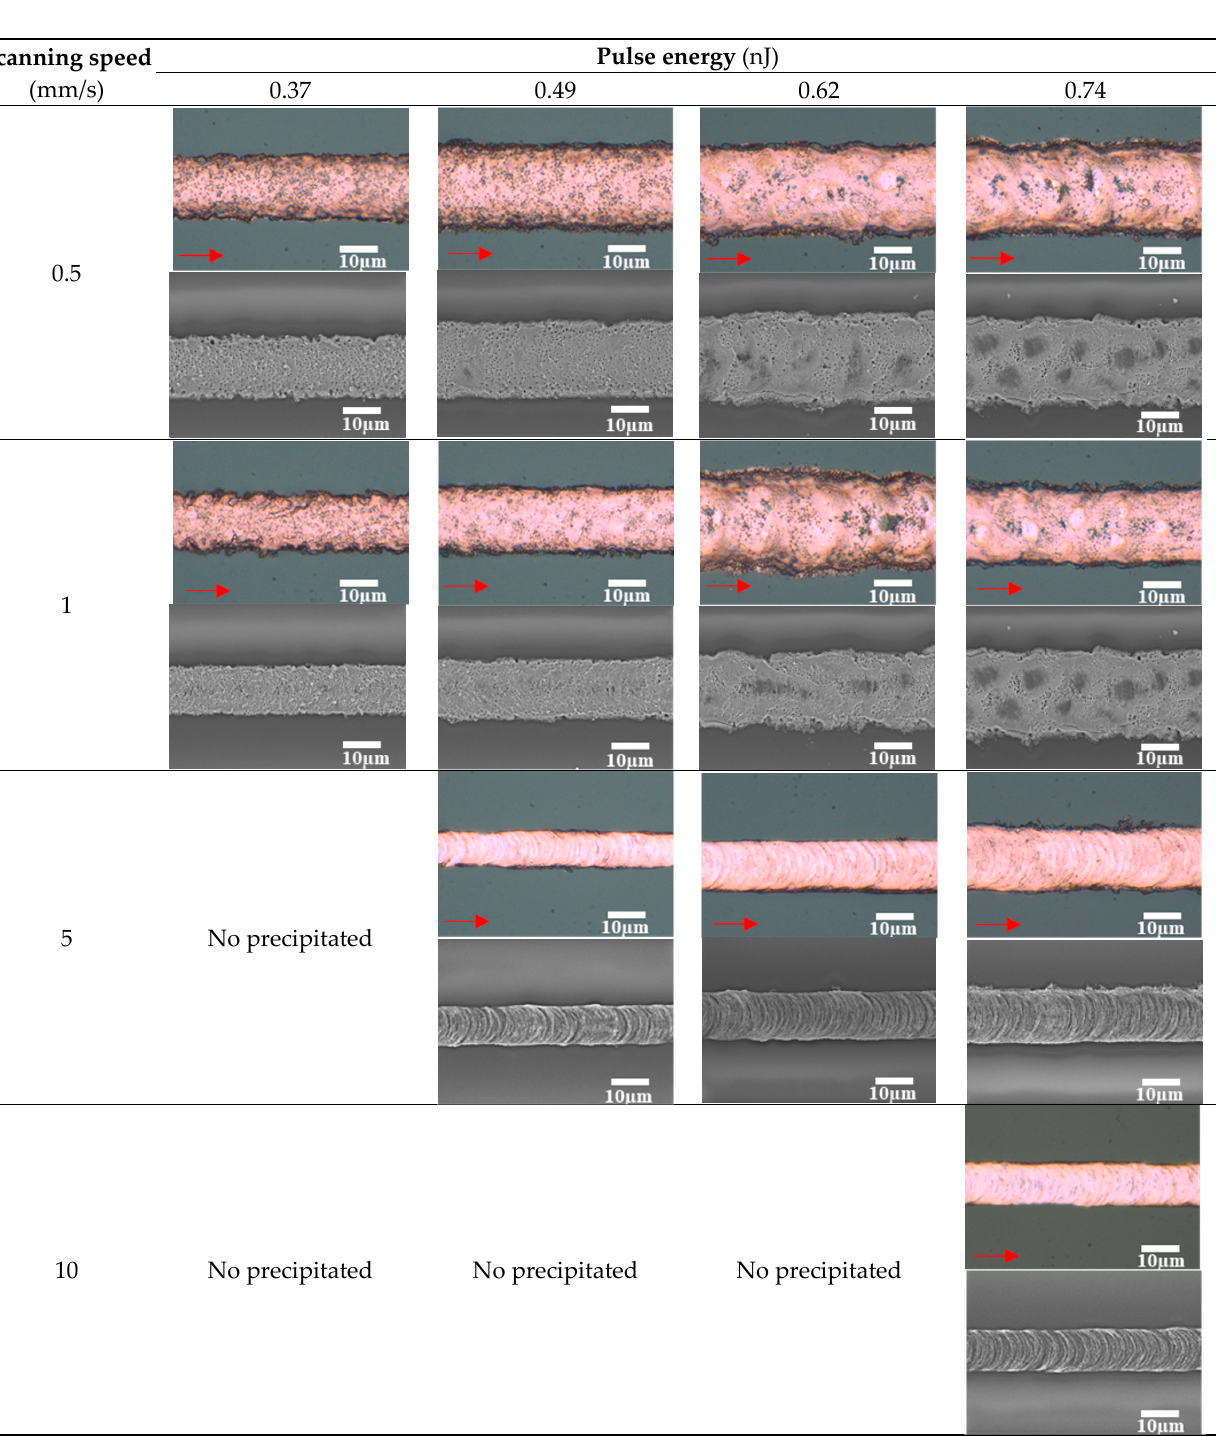
Figure 2. Optical and SEM microscope images on glass substrates at a scanning speed of 0.5 ‒ 10 mm/s and pulse energy of 0.37 ‒ 0.74 nJ.